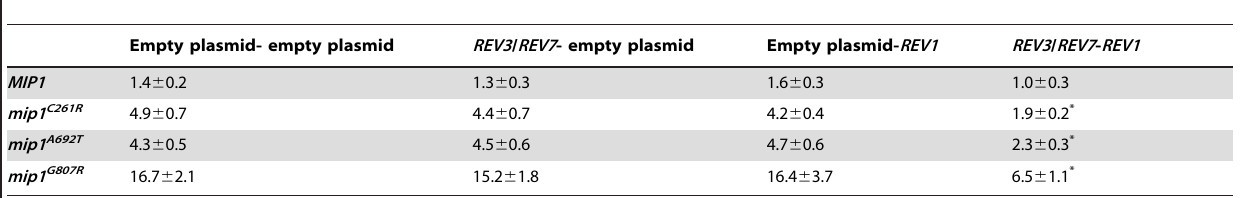
Table 3. Ery R mutant frequency in mip1 mutant strains overexpressing REV3 , REV7 and/or REV1 .